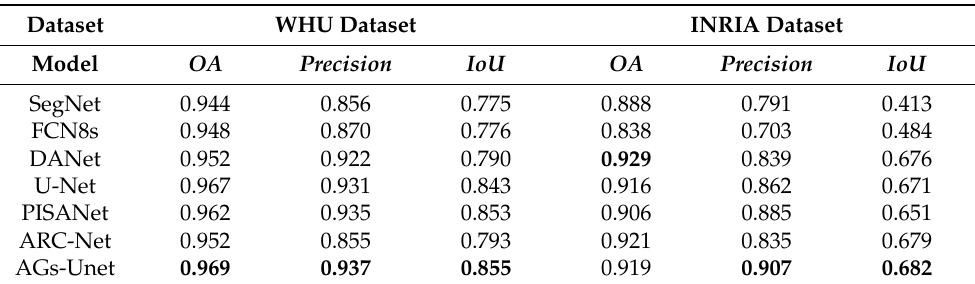
Table 4. Quantitative evaluation results of the three indexes of each model in the WHU dataset and the INRIA dataset. The best scores are highlighted in bold.